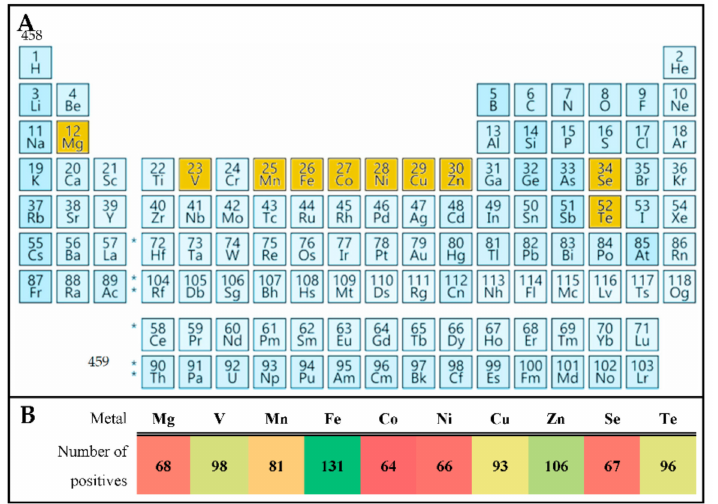
Figure 4. Variant metal(loid)s tested in CAS assay. ( A ) Chosen elements highlighted in yellow. ( B ) Tallied number of positive results from Tables 1 and